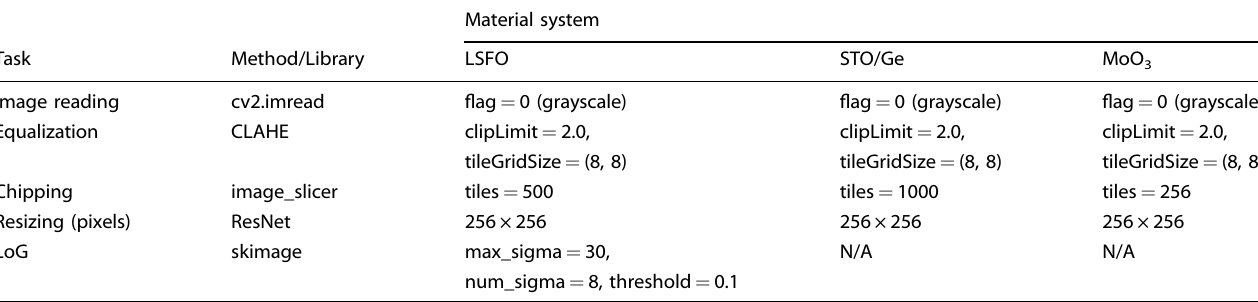
Table 1. Image preprocessing parameters listed by material system and task with respective libraries/methods for implementation. Material